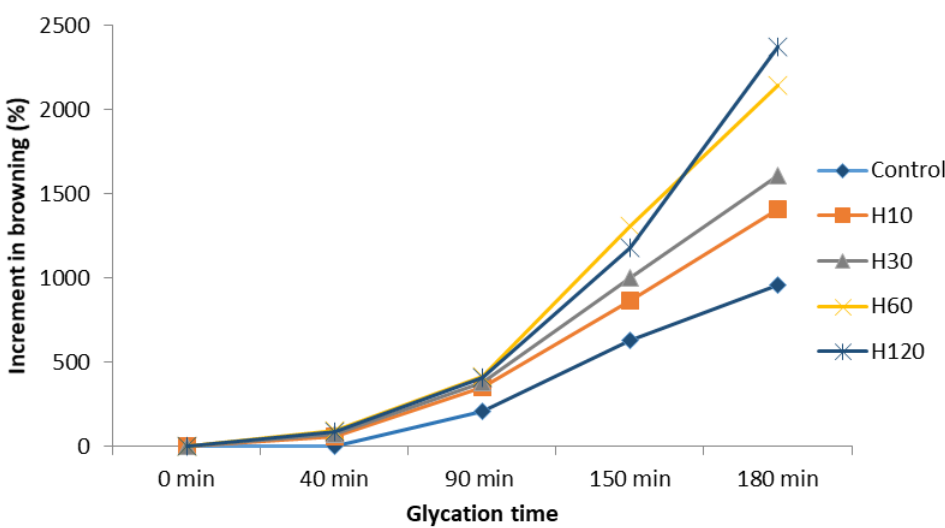
Figure 1. Increment in browning during the Maillard glycation of the control and the hydrolysates. The increments were calculated from the browning of each sample at time 0.